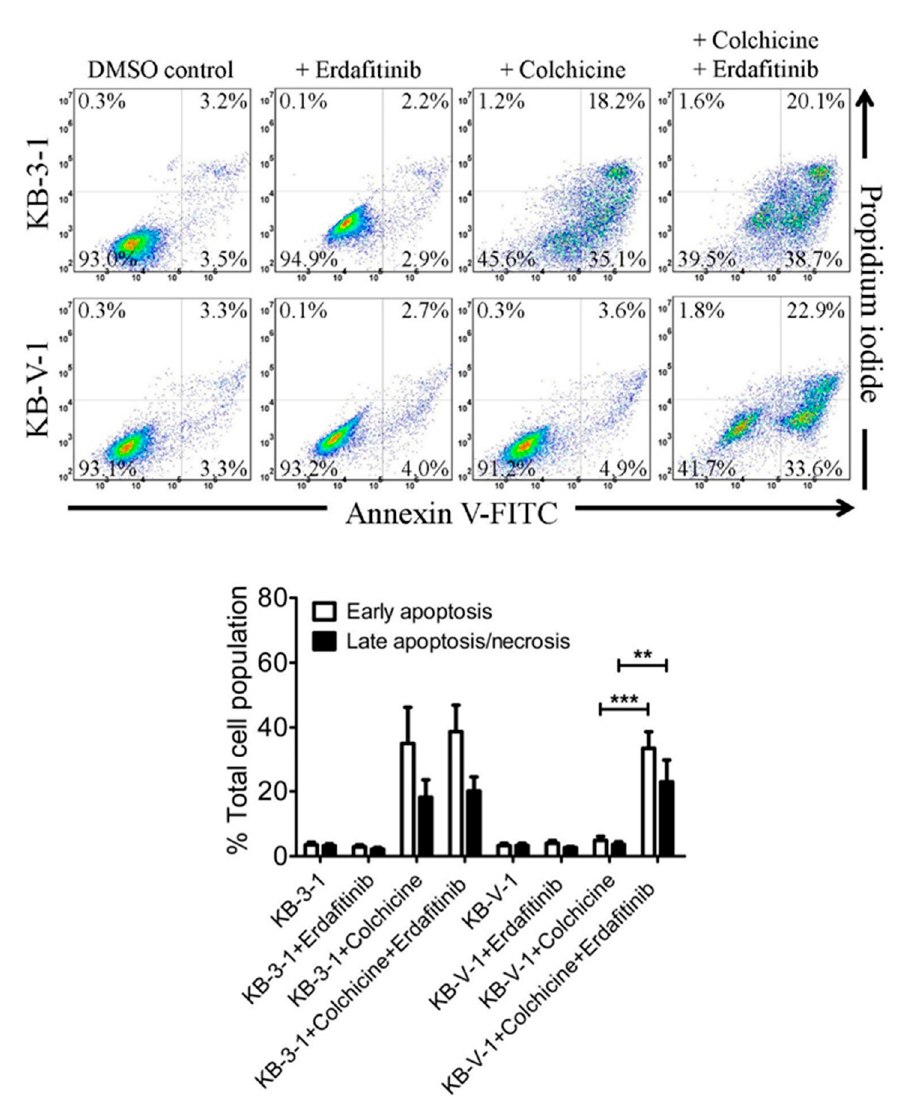
Figure 4. Erdafitinib sensitizes ABCB1-overexpressing multidrug-resistant cancer cells to apoptosis induction by an ABCB1 substrate drug. The representative flow cytometric dot plots (upper panel) and quantification (lower panel) of drug-sensitive KB-3-1 cells and the ABCB1-overexpressing multidrug resistant KB-V-1 cells treated with either DMSO (control), 5 µ M of erdafitinib ( + erdafitinib), 500 nM of colchicine ( + colchicine), or a combination of colchicine and erdafitinib ( + colchicine + erdafitinib). Cells were treated with the respective drug regimens and analyzed by flow cytometry as described in the Materials and Methods. The corresponding quantification data are presented as the mean ± SD calculated from at least three independent experiments. ** p < 0.01; *** p < 0.001, versus the same treatment in the absence of erdafitinib.